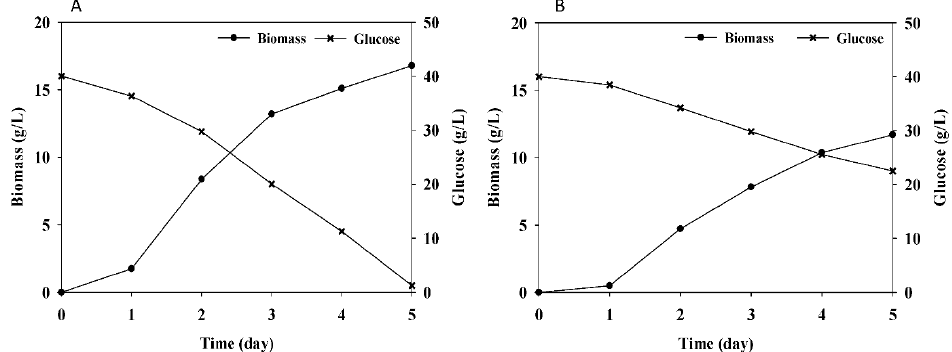
Figure 4. Biomass concentration and glucose consumption of Mortierella alpina FU30797 with TPW hydrolysate in the shake flask. ( A ) enzymatic hydrolysate, ( B ) acidic hydrolysate (initial glucose concentration was 40 g/L). Table 3. Biomass concentration, lipid content, lipid production and ARA ratio of Mortierella alpina FU30797 after 5 days of cultivation with TPW acidic and enzymatic hydrolysate.